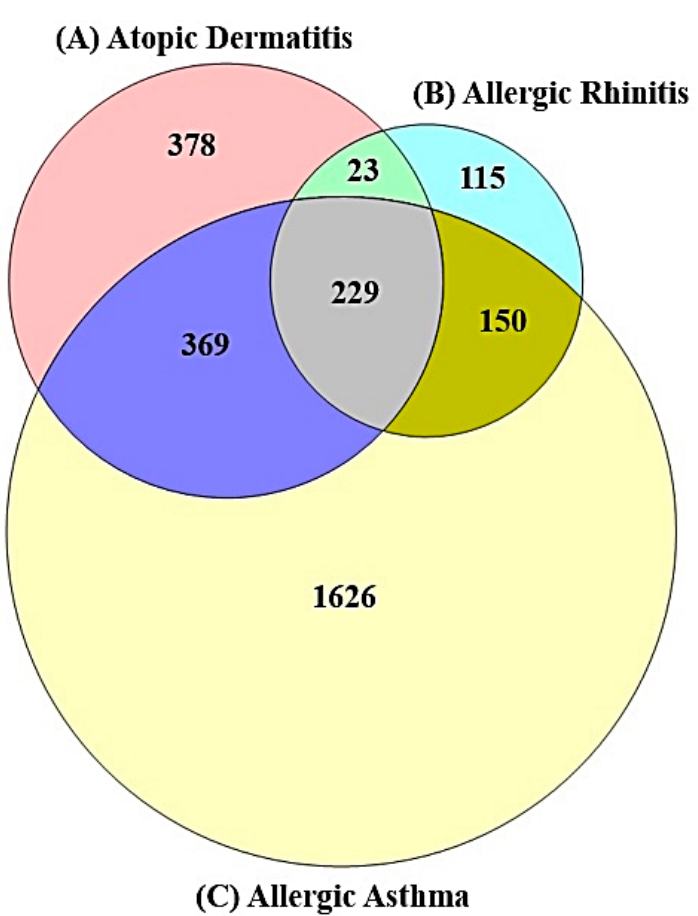
Figure 2. A total of 229 targets related to Atopic March (AM). ( A ) A total of 999 targets related to Atopic Dermatitis (AD). ( B ) A total of 517 targets related to Allergic Rhinitis (AR). ( C ) A total of 2374 targets related to Allergic Asthma (AA).